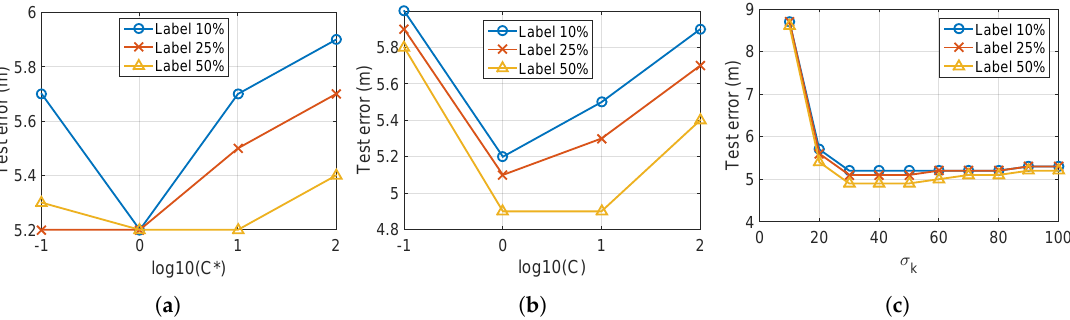
Figure 9. Impact of the parameters C , C ∗ , and σ k in Step 4 of Algorithm 1. Other parameters used in the prior Step 3 are set to µ 1 = 1, µ 2 = 3, and λ = 5. ( a ) Impact of the ratio C ∗ / C when C = 40. ( b ) Impact of the values of C and C ∗ if the ratio C / C ∗ is fixed, varying C and C ∗ with constraint C / C ∗ = 1. ( c ) Impact of the value of σ k when C = 40 and C ∗ = 40. Table 1. Selected parameter values.